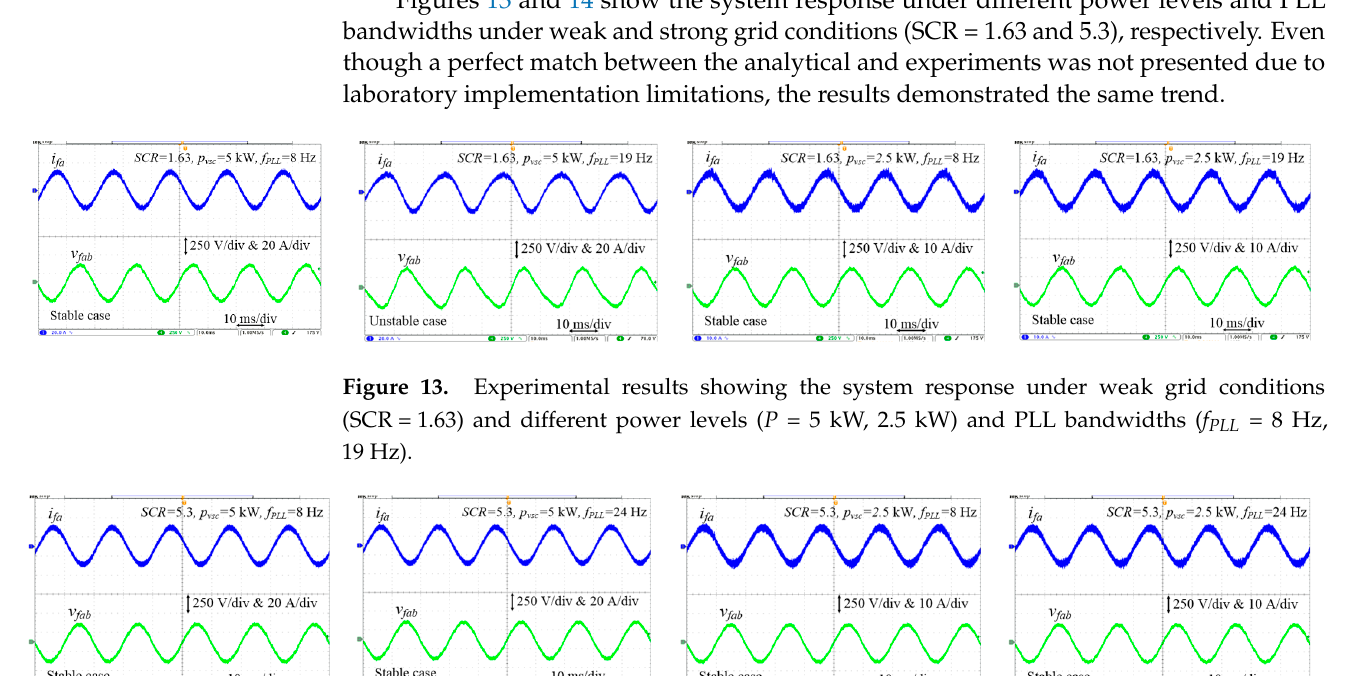
Figure 14. Experimental results showing the system response under strong grid conditions (SCR = 5.3) and different power levels ( P = 5 kW, 2.5 kW) and PLL bandwidths ( f PLL = 8 Hz, 24 Hz).